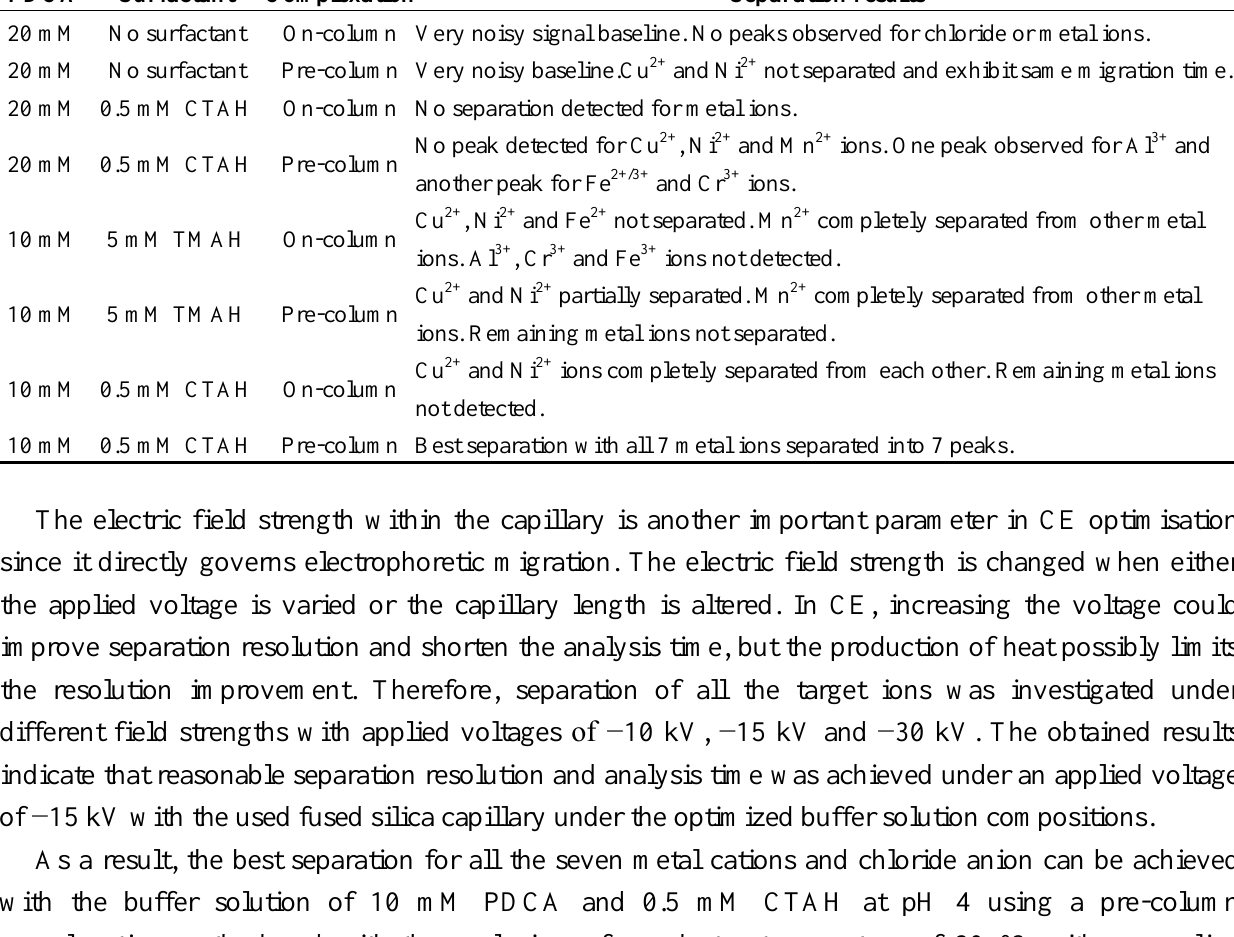
Table 1. Optimisation of buffer solution and complexation method for separation of seven metal ions.